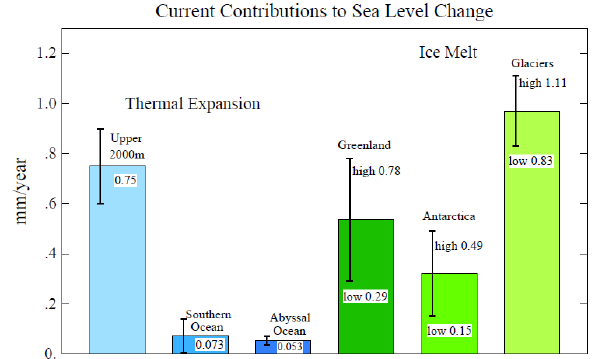
Fig.14. Estimated contributions to sea level change in 2005-2010. Upper ocean thermal expansion with error bar is from von Schuckmann and Le Traon (2011), while Southern Ocean and Abyssal Ocean data are from Purkey and Johnson (2010). Vertical whiskers for ice melt show the high and low range of estimates, the green bars being the mean of this range.